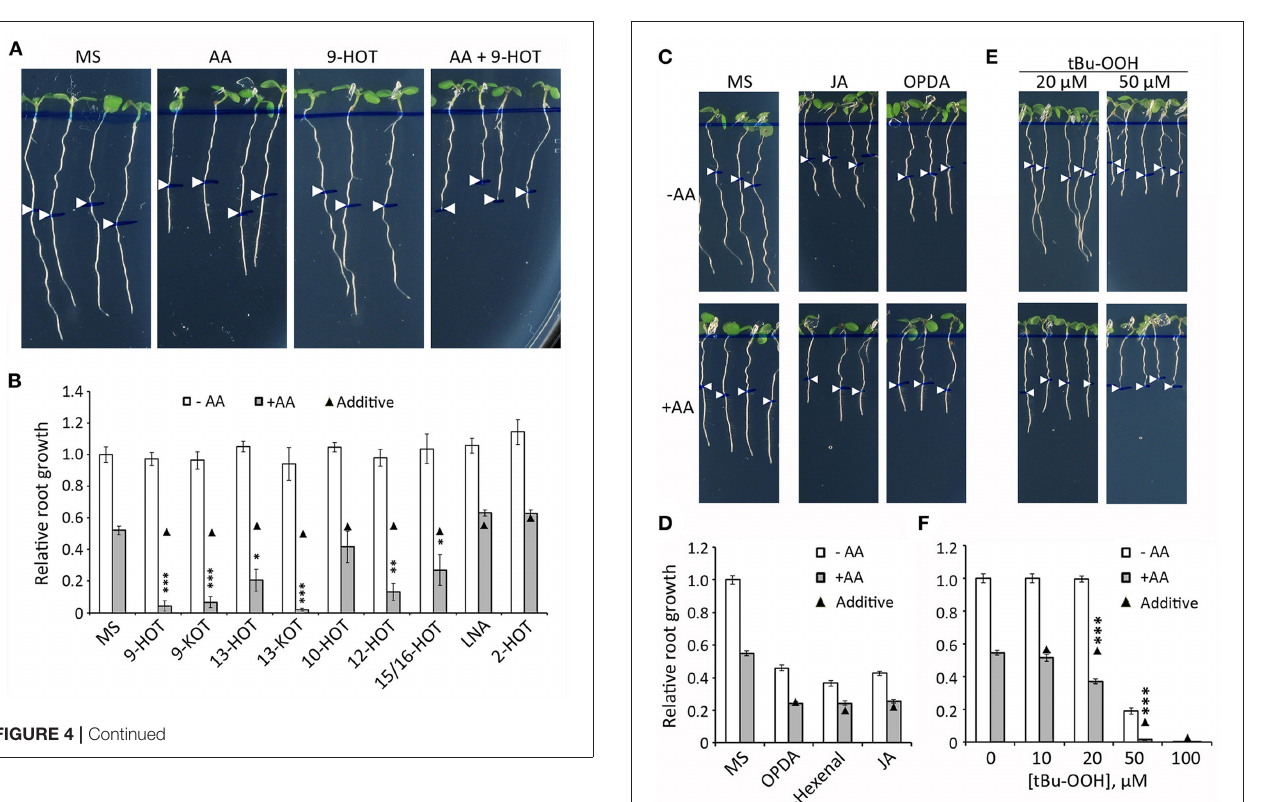
activity, showing that alternative respiration was not